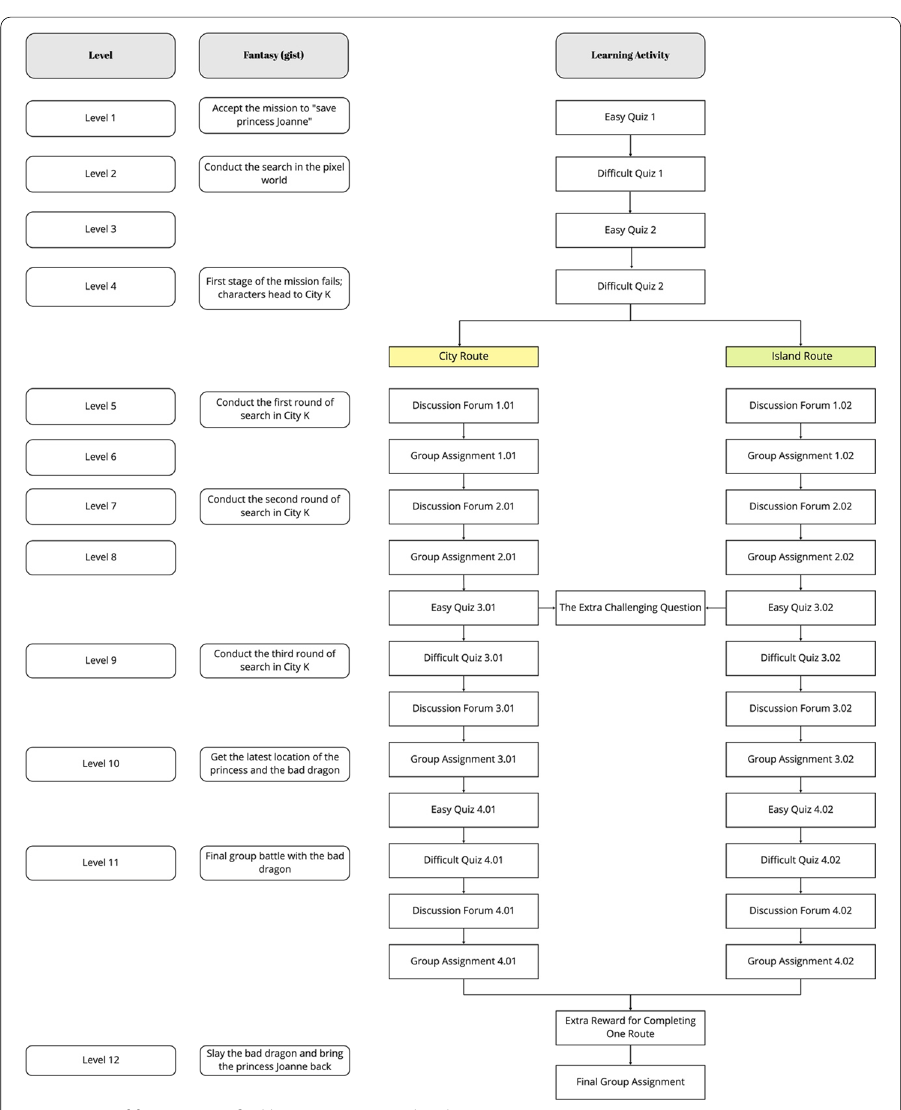
Fig. 3 Map of fantasy gamified learning activities